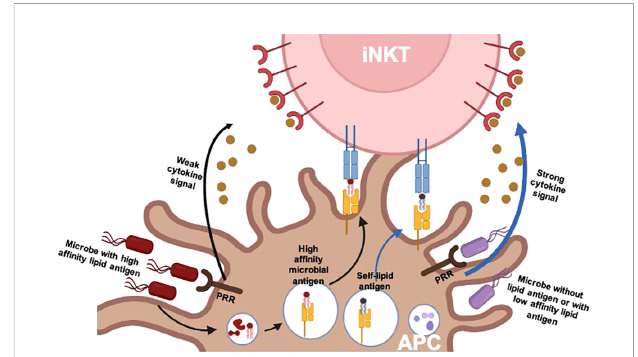
FIGURE 1 TCR and/or cytokine-driven iNKT cell activation. There are two pathways involved in the physiological activation of iNKT cells: 1) for pathogens expressing af fi nity lipid antigens, iNKT cell activation is dominantly driven by TCR signals provided by the complex of high- af fi nity microbial lipid antigen presented by CD1d of an APC. It is less dependent on additional cytokine signals, which are provided by APCs after stimulation of pattern recognition receptors (PRRs). 2) For pathogens lacking lipid antigens or with low-af fi nity lipid antigens, iNKT cell activation is dominantly driven by cytokine signals. The engagement of microbial products with PRRs leads to APC production of pro-in fl ammatory cytokines such as IL-12. In this case, TCR signals are commonly still required, which is provided by self-lipid or low- af fi nity lipid antigens. TCR, T-cell receptor; iNKT, invariant natural killer T; APC, antigen-presenting